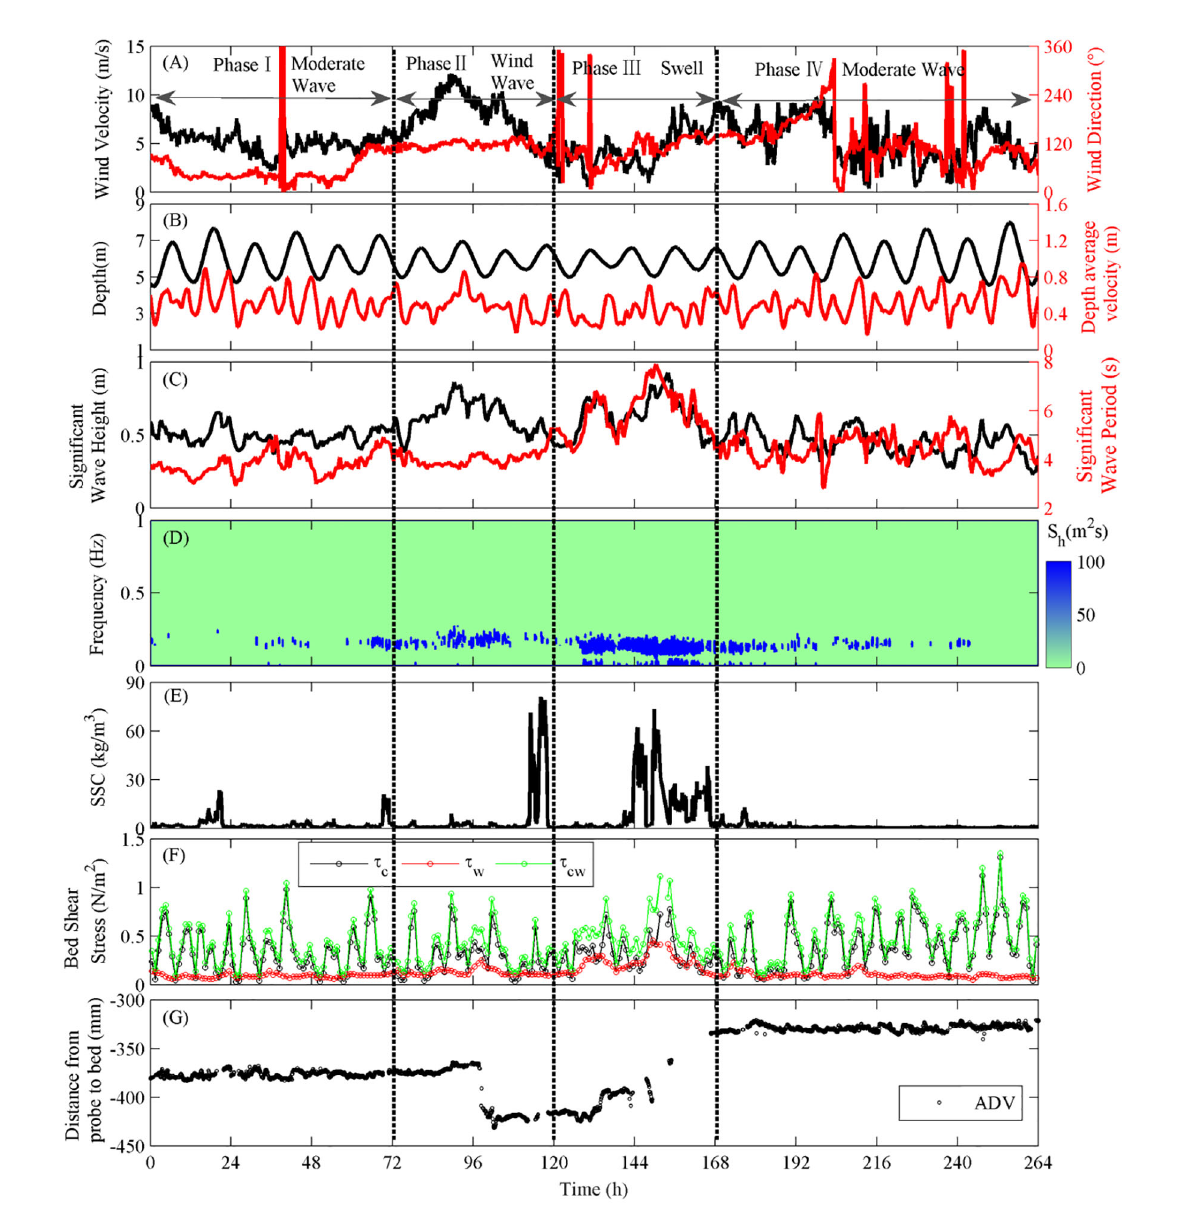
FIGURE 3 Time series of (A) wind velocity and direction, (B) water depth and depth-averaged current velocity, (C) SWH and SWP, (D) energy spectra of water level (